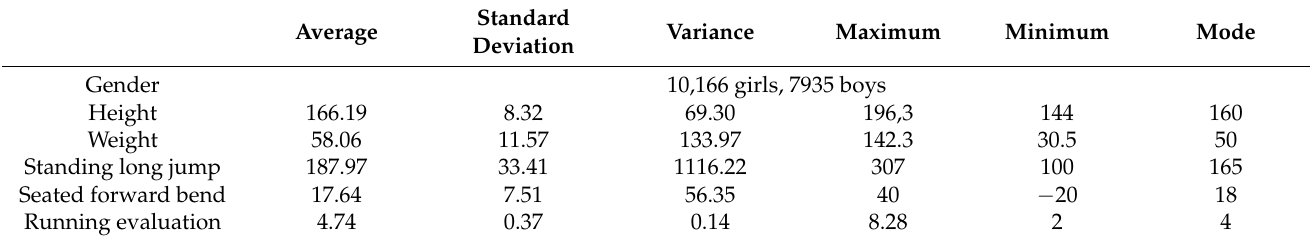
Table 3. The Data Survey